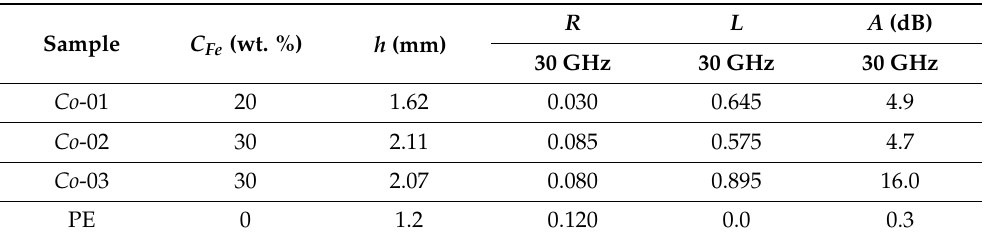
Table 13. The coefficients of attenuation A , reflection R , and loss L of samples of composite materials based on cobalt-containing